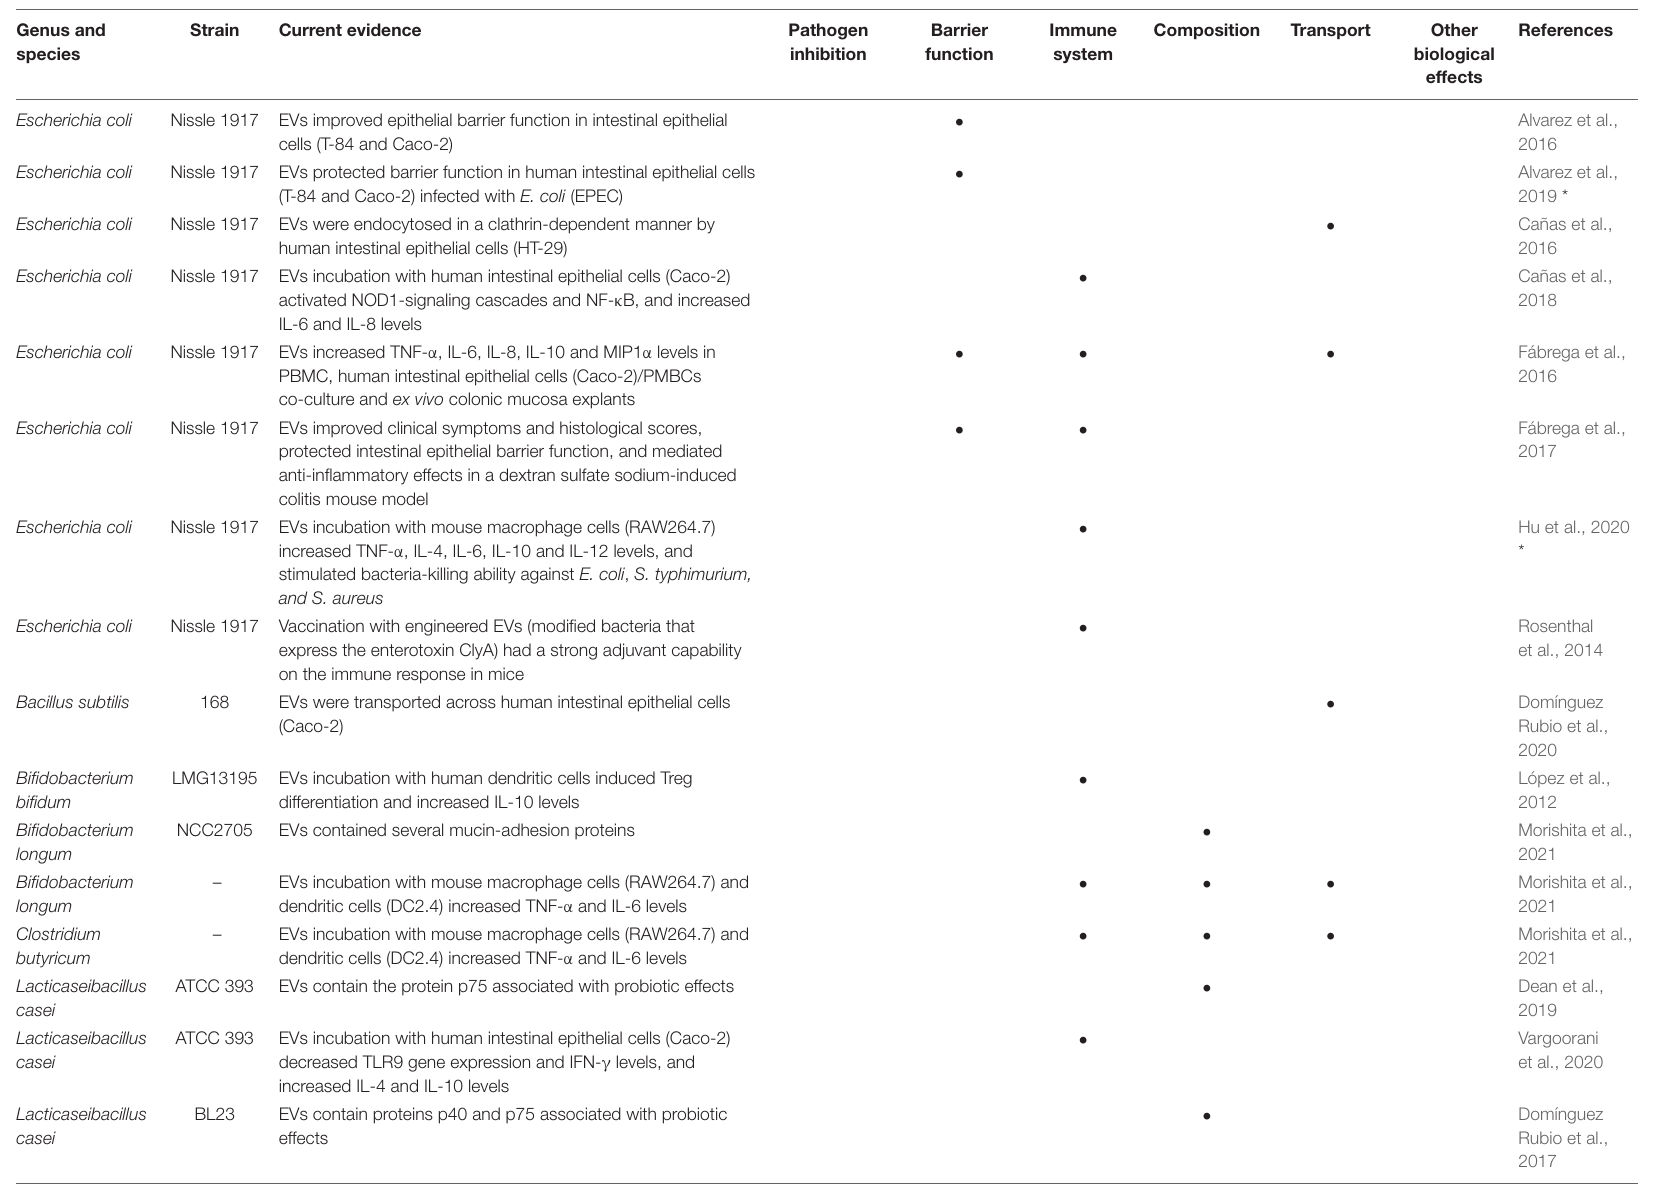
TABLE 1 | Biological effects of EVs released by species that comprise probiotic strains. Genus and